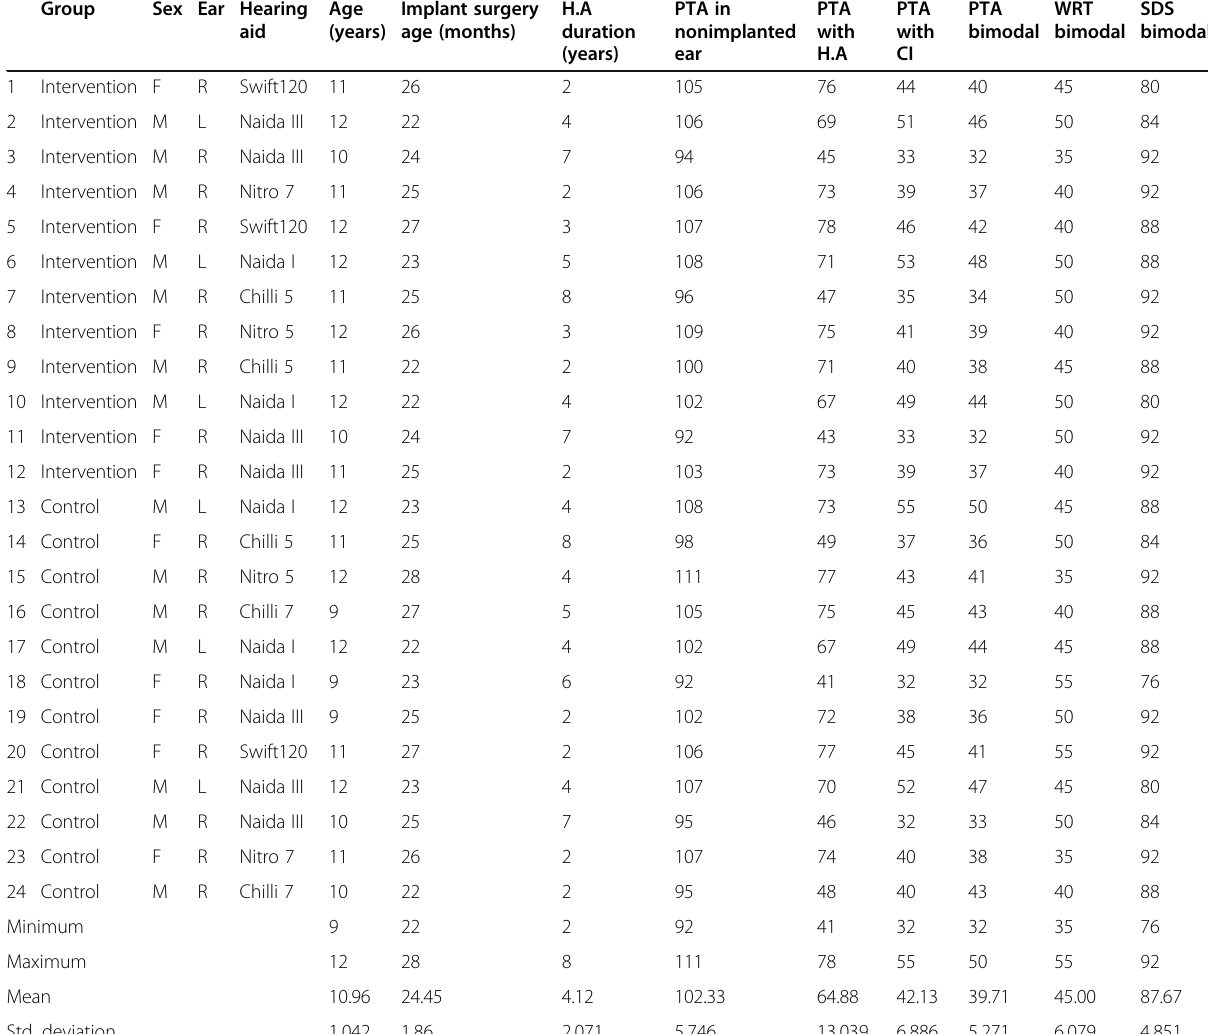
Table 2 Participant ’ s demographic and audiometric characteristics